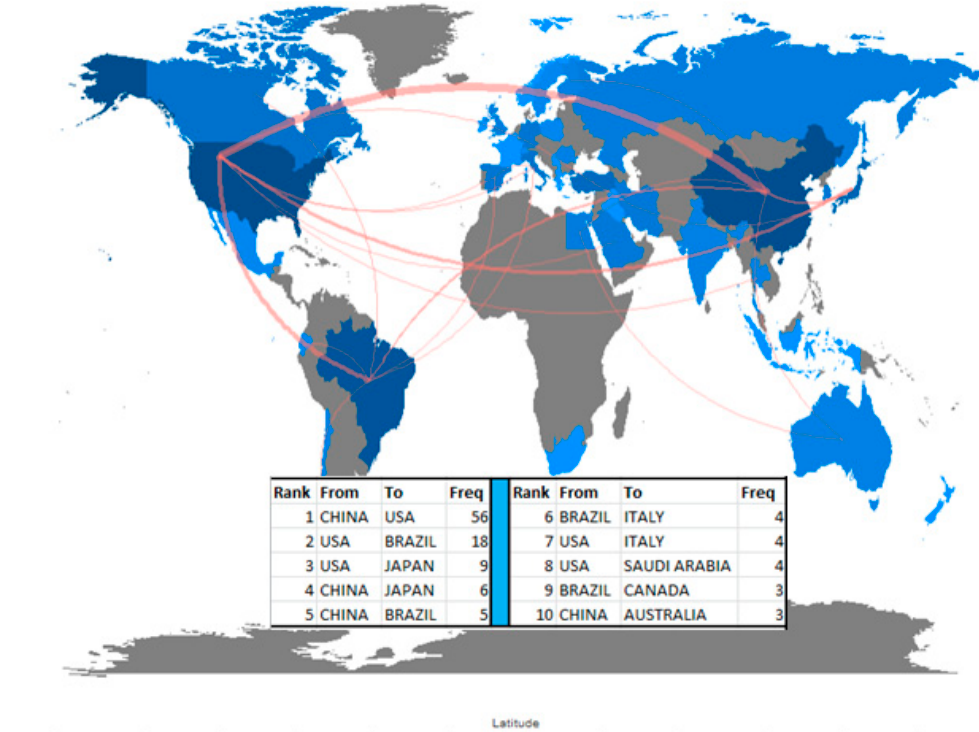
Figure 7. Country collaboration map on dental adhesive literature.